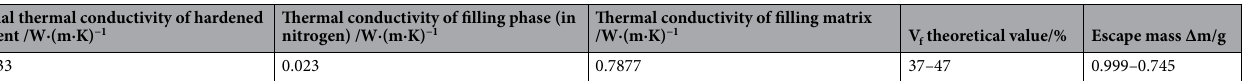
Actual thermal conductivity of hardened cement /W·(m·K) −1